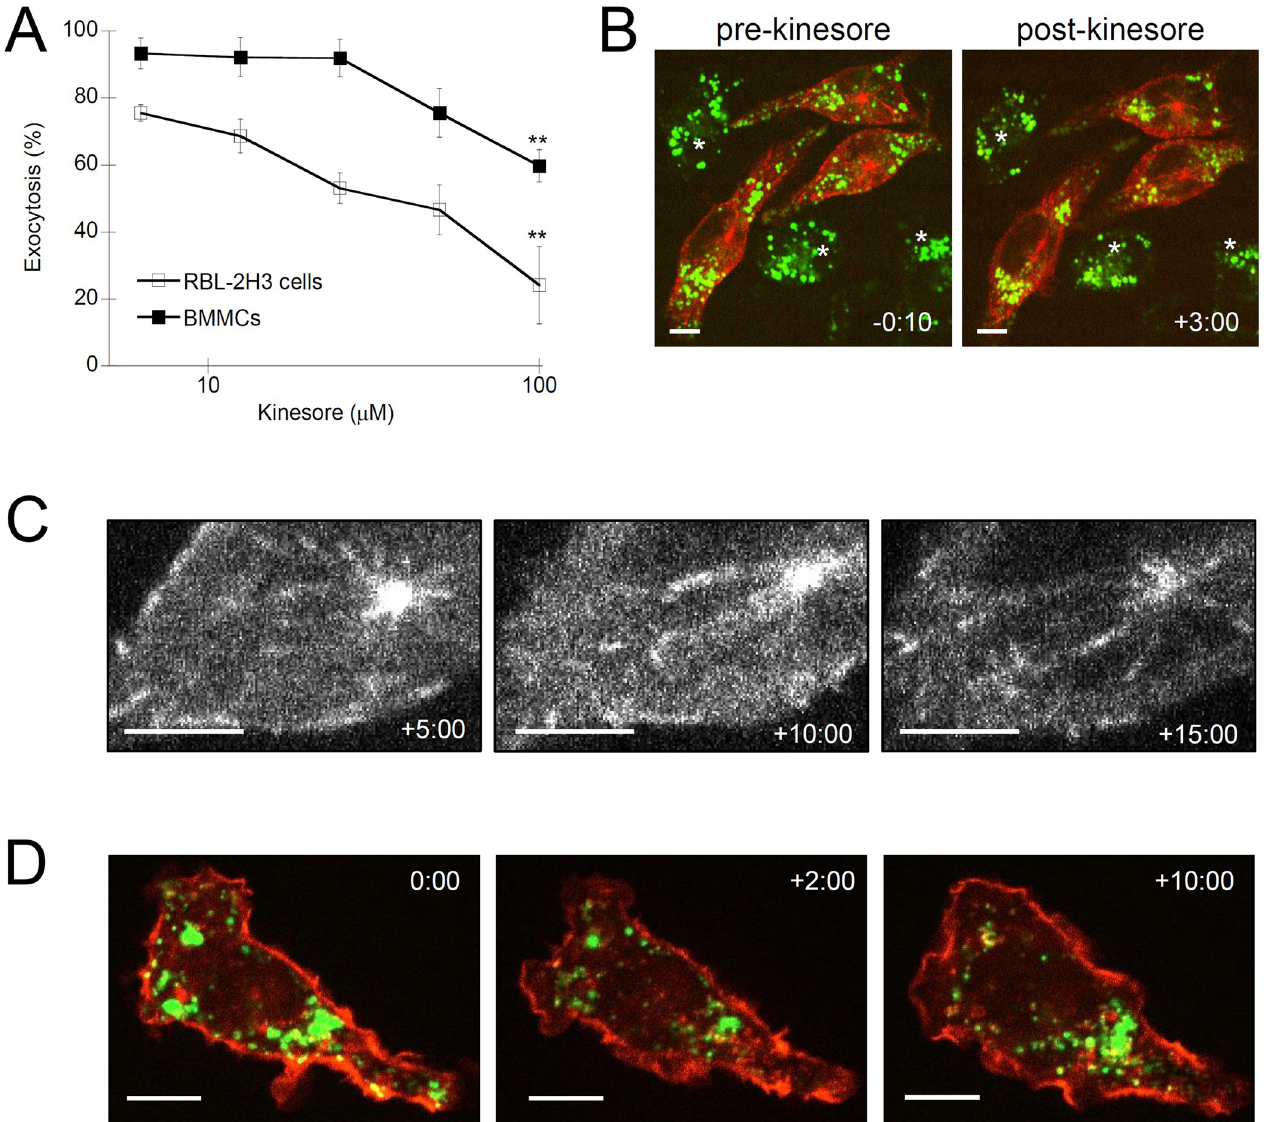
Fig 3. Kinesore, a small-molecule activator of microtubule motors, inhibits mast cell granule exocytosis. A) Exocytosis assay of RBL-2H3 cells and BMMCs that were pre-treated with kinesore for 30 min prior to antigen-stimulation. Exocytosis was assayed as the percent β -hexosaminidase released of total, normalized to vehicle (DMSO) controls. 100 μ M kinesore showed statistically significant inhibition of both RBL-2H3 cell and BMMC exocytosis via Student’s t -test ( �� , p = 0.0104 and 0.0088 for RBL-2H3 and BMMC respectively; n = 3). B) Representative confocal images from live-cell imaging of microtubule dynamics and granule movement of mast cells treated with 100 μ M kinesore (see S6 Video via https://doi.org/10.6084/m9.figshare.19349573.v1). RBL-2H3 cells were transfected with EB3-tdTomato to label nascent microtubules and incubated with LysoTracker green to label granules. Cells were imaged for 1 min, then antigen-stimulated and concurrently 100 μ M kinesore was added, followed by 15 min of imaging showing the movement of granules to the perinuclear region while microtubules project to the cell periphery. C) Magnified images from the 5 min– 15 min time points showing the formation of EB3-tdTomato puncta are not affected by kinesore. D) Representative confocal images from live-cell imaging of actin dynamics and granule movement of mast cells treated with 100 μ M kinesore (see S7 Video via https://doi.org/10.6084/m9.figshare.19349579.v1). RBL-2H3 cells were transfected with Lifeact-Ruby to label nascent F- actin and incubated with LysoTracker green to label granules. Cells were imaged for 1 min, then antigen-stimulated and concurrently 100 μ M kinesore was added followed by 15 min of imaging. Scale bar, 10 μ m; � indicates untransfected cells.